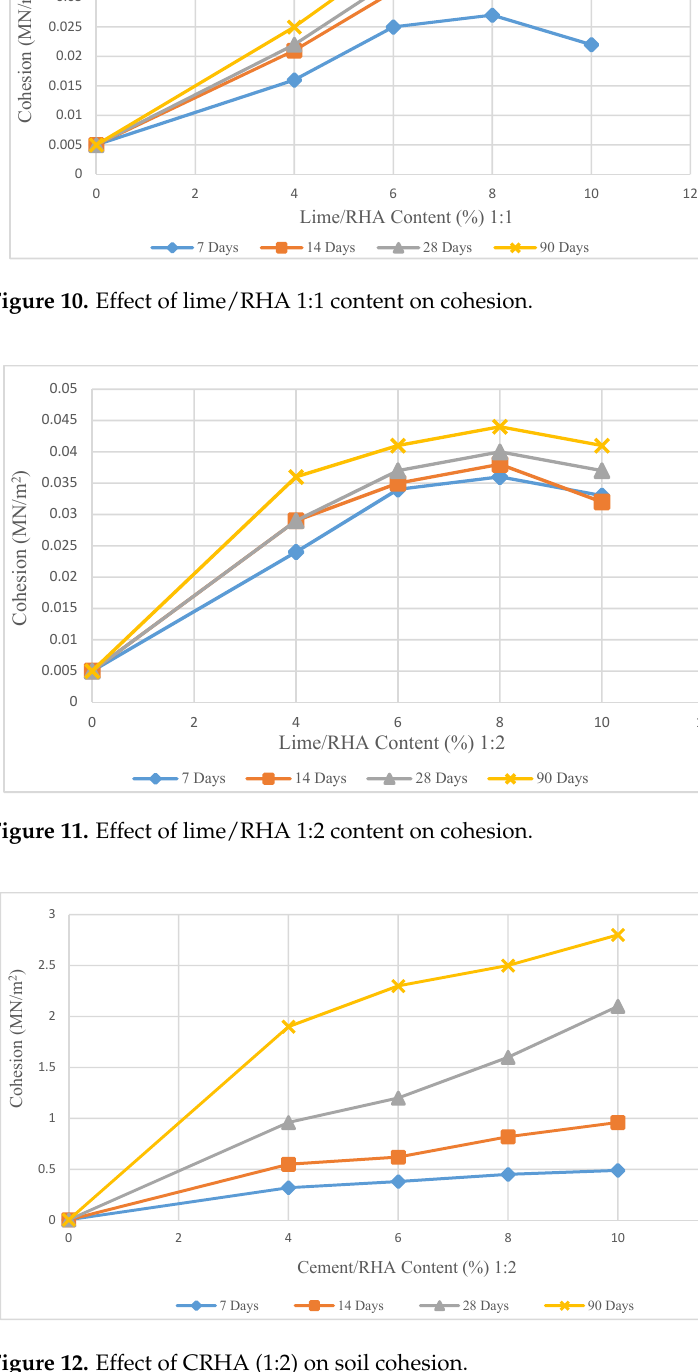
Figure 12. Effect of CRHA (1:2) on soil cohesion.